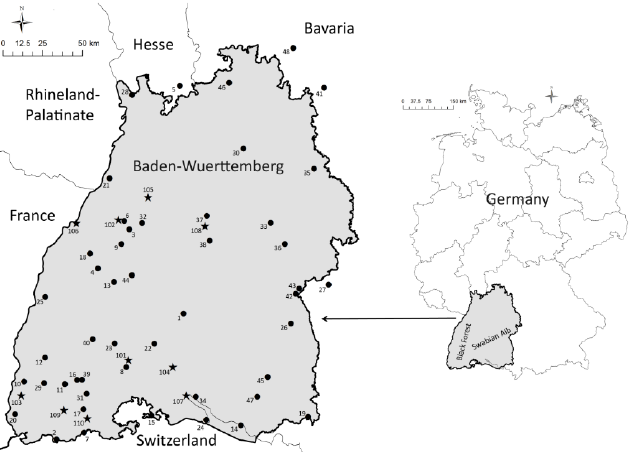
Figure 1. The study area Baden-Wuerttemberg in Southwest Germany and locations of German Weather Service (DWD) stations. Dots indicate parameterization dataset (DS1) stations; stars indicate validation dataset (DS2) stations. Table 1. List of DWD stations and corresponding data features. DS1 stations are indicated by identification numbers (ID) 1–48; DS2 stations are indicated by ID values 101–110. speed near the surface values; h S : height.